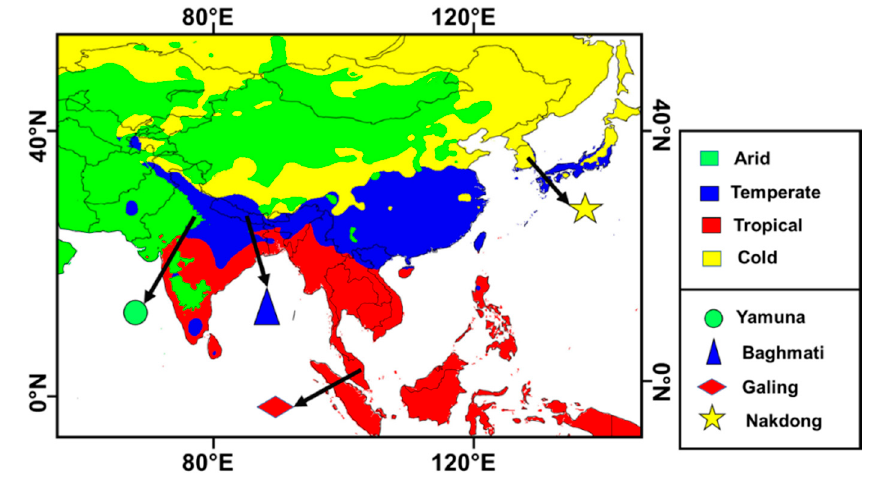
Figure 1. Locations of four different rivers and their corresponding major Koppen-Geiger climate